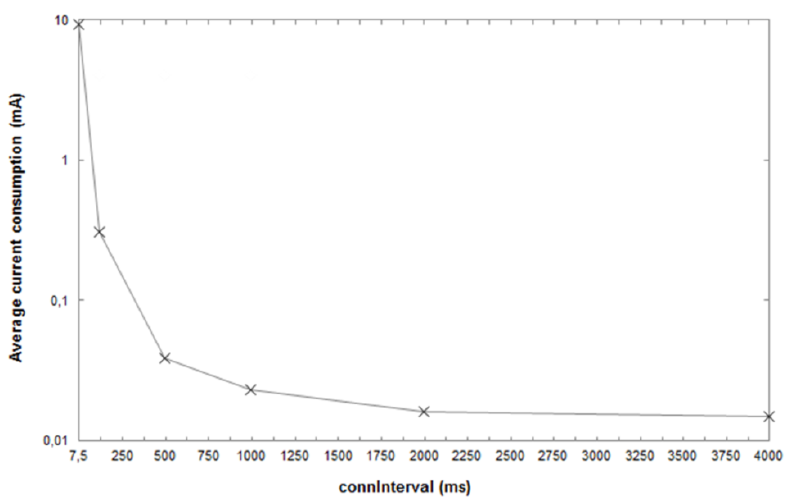
Figure 4. Average current consumption measured in a CC2540 slave, for the ATT one- way communication and connSlaveLatency = 0.